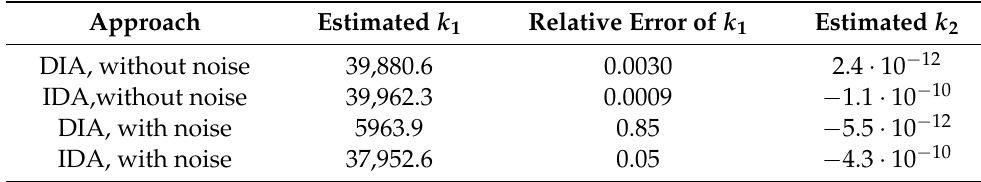
Table 1. Comparison of stiffness identification in the Lin-Ewins